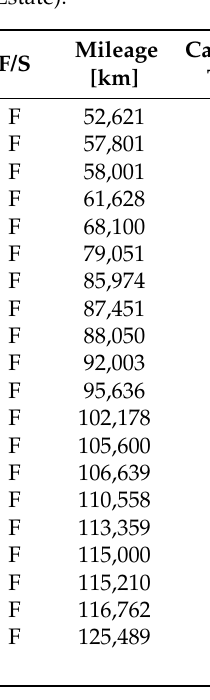
Table 1. Failure/suspension date of contactor (F/S–failure, suspension, car body type: H–hatchback,